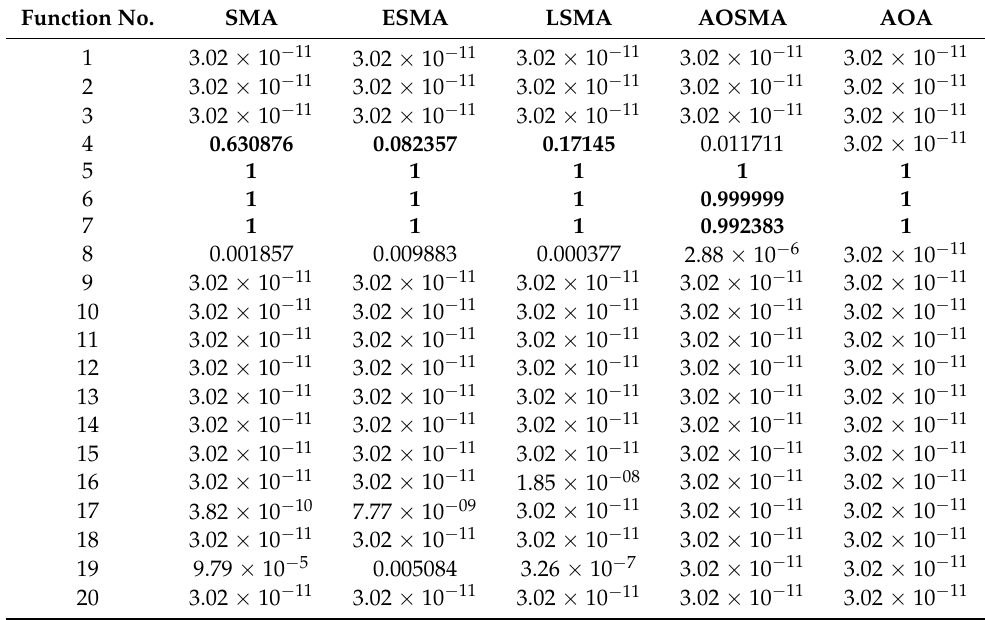
Table 5. p -values for S 2 SMA versus other competitors on a large scale. Function No.